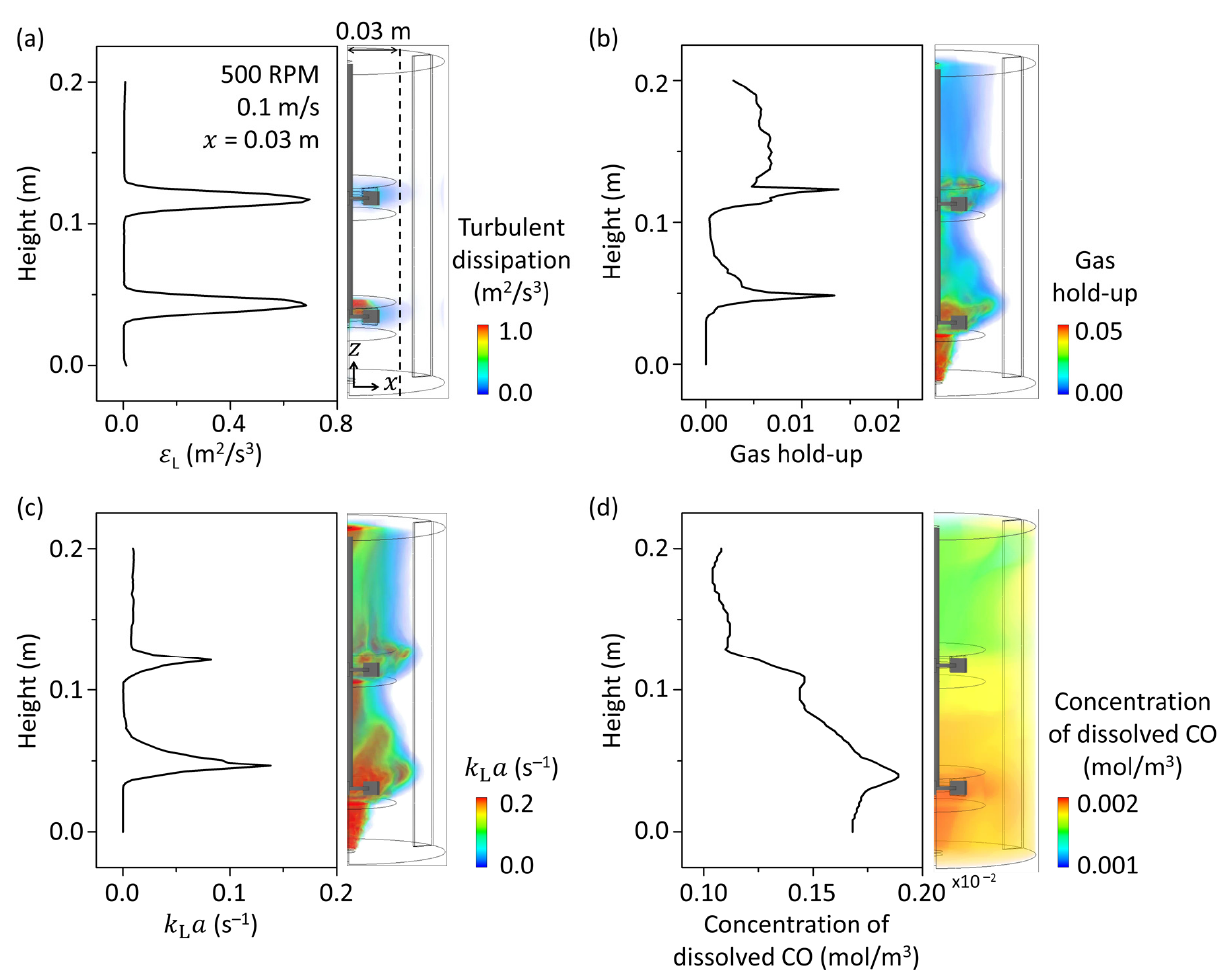
Figure 3. Axial distribution of the ( a ) turbulent dissipation rate, ( b ) gas hold-up, ( c ) mass transfer coefficient ( k L a ) , and ( d ) dissolved carbon monoxide concentration at x = 0.03 m with 500 RPM and an inlet velocity of 0.1 m/s.